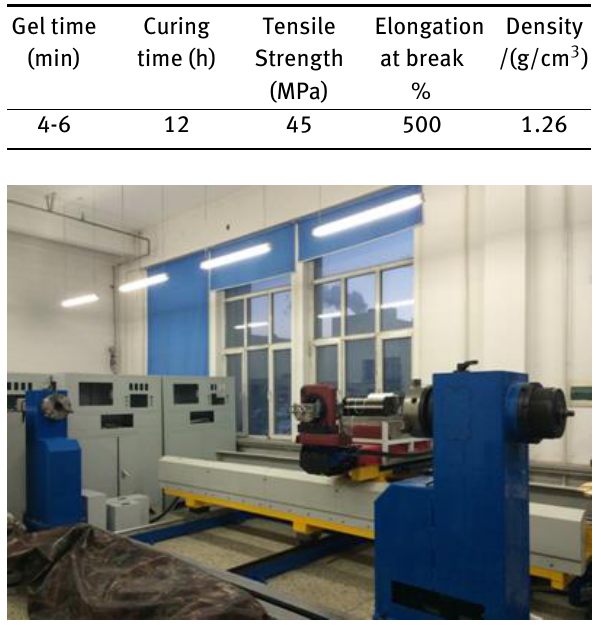
Table 1: Material parameters of polyurethane rubber